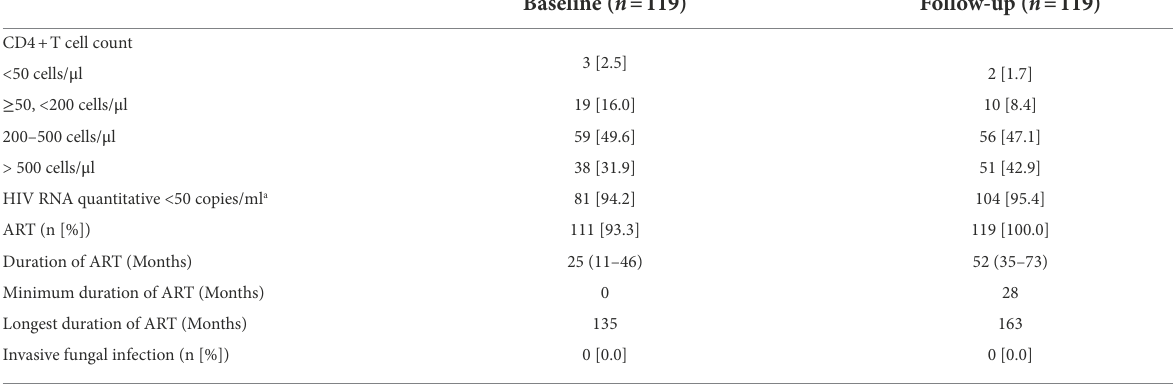
TABLE 5 Baseline characteristics and follow-up of pathogenic filamentous fungi carriers with HIV infection.